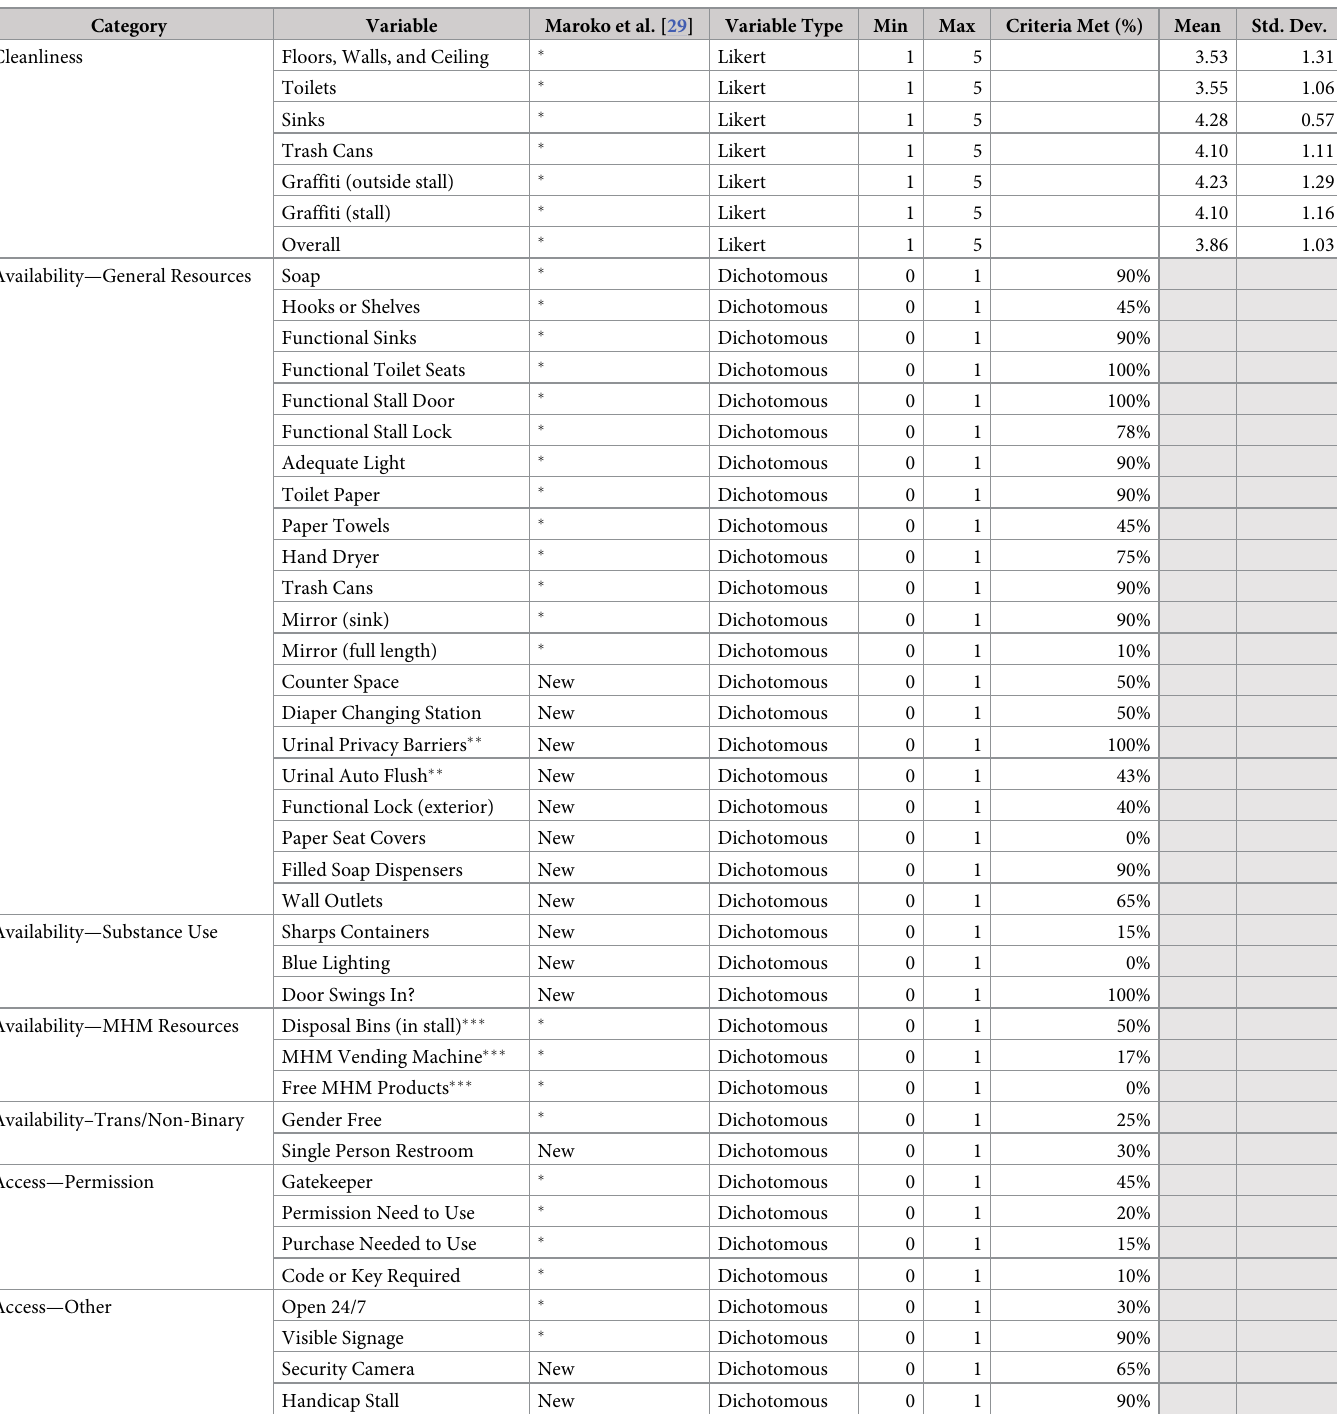
Table 1. Toilet audit